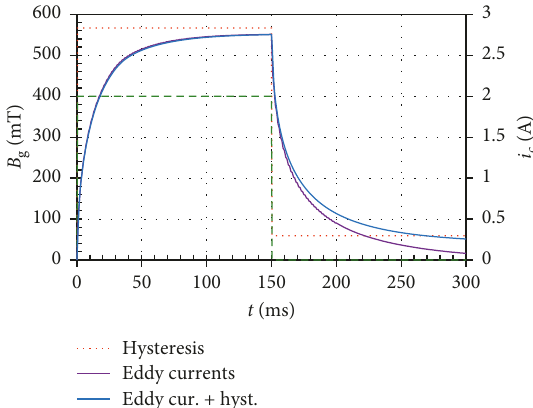
Figure 19: Transient FE model: time history of magnetic flux density and electric current (dashed green